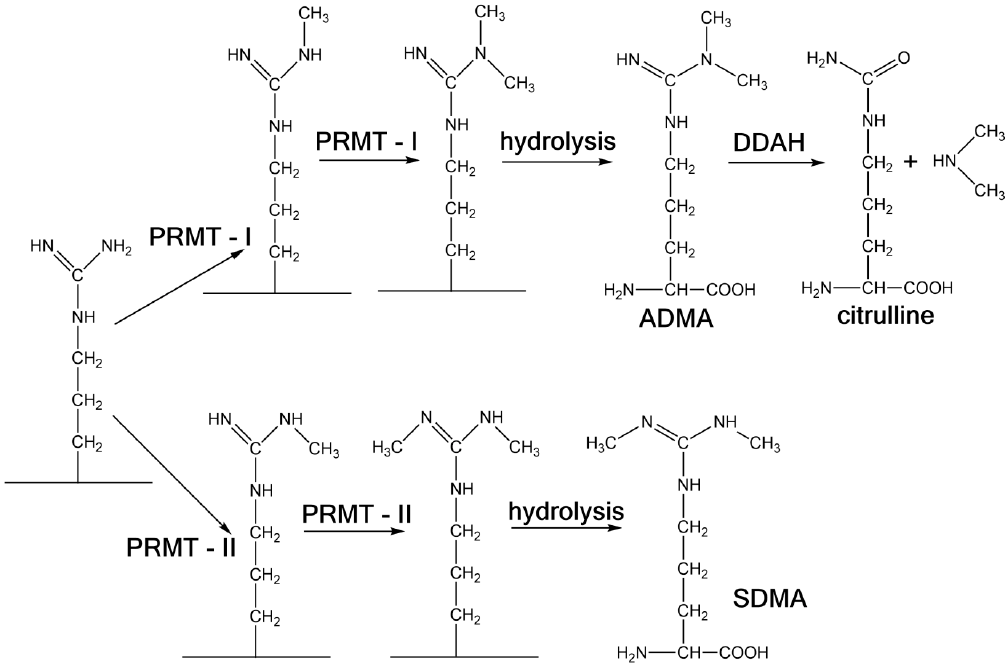
Figure 1. Double methylation of the side chains of arginine bonded to proteins through the effect of the protein arginine methyltransferases of Class I (PRMT-I) and Class II (PRMT-II), releasing ADMA and SDMA by protein hydrolysis; degradation of ADMA is through the effect of dimethyl arginine dimethylaminohydrolase (DDAH).